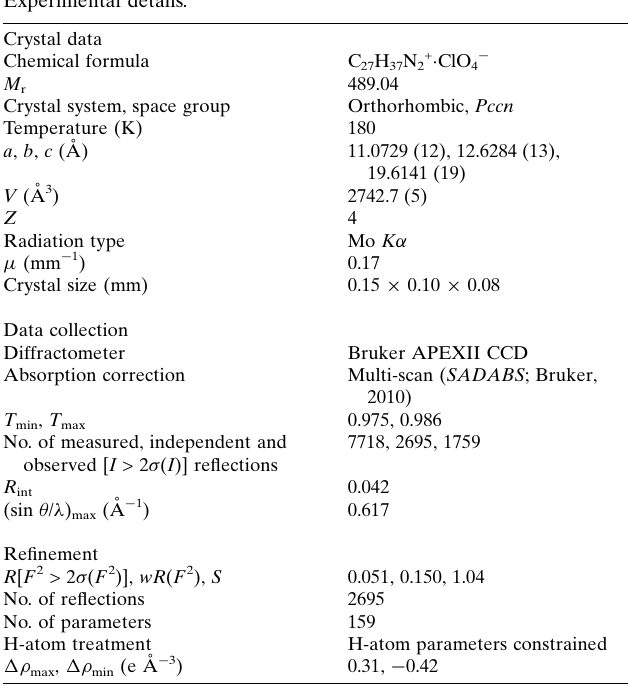
Table 2 Experimental details. Crystal data Chemical formula